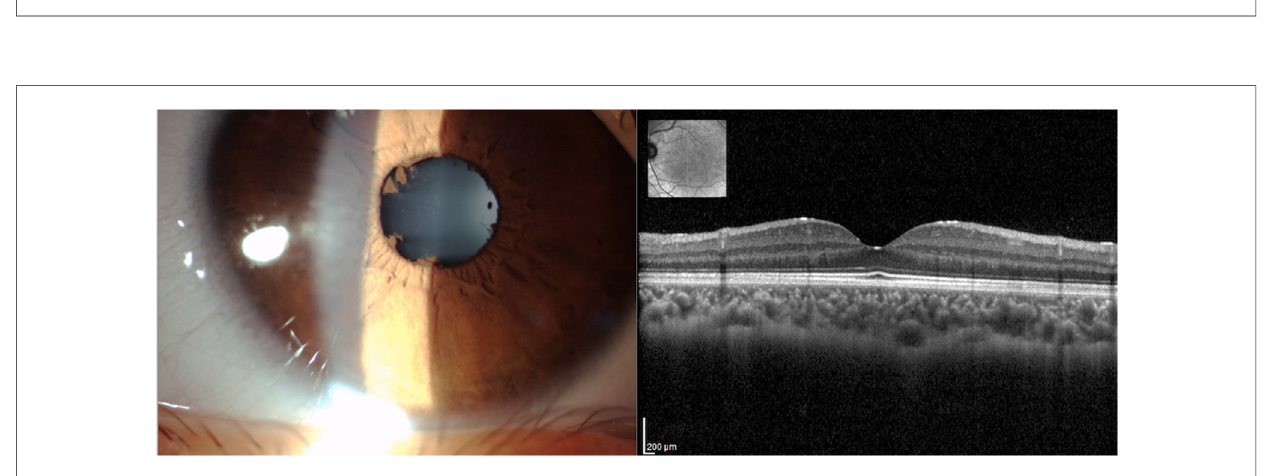
FIGURE 1 Knee ultrasound of case 2 showing active synovitis. °, Power Doppler signal of synovial tissue; arrows, synovial hypertrophy; <, growing cartilage; big arrow, bone.